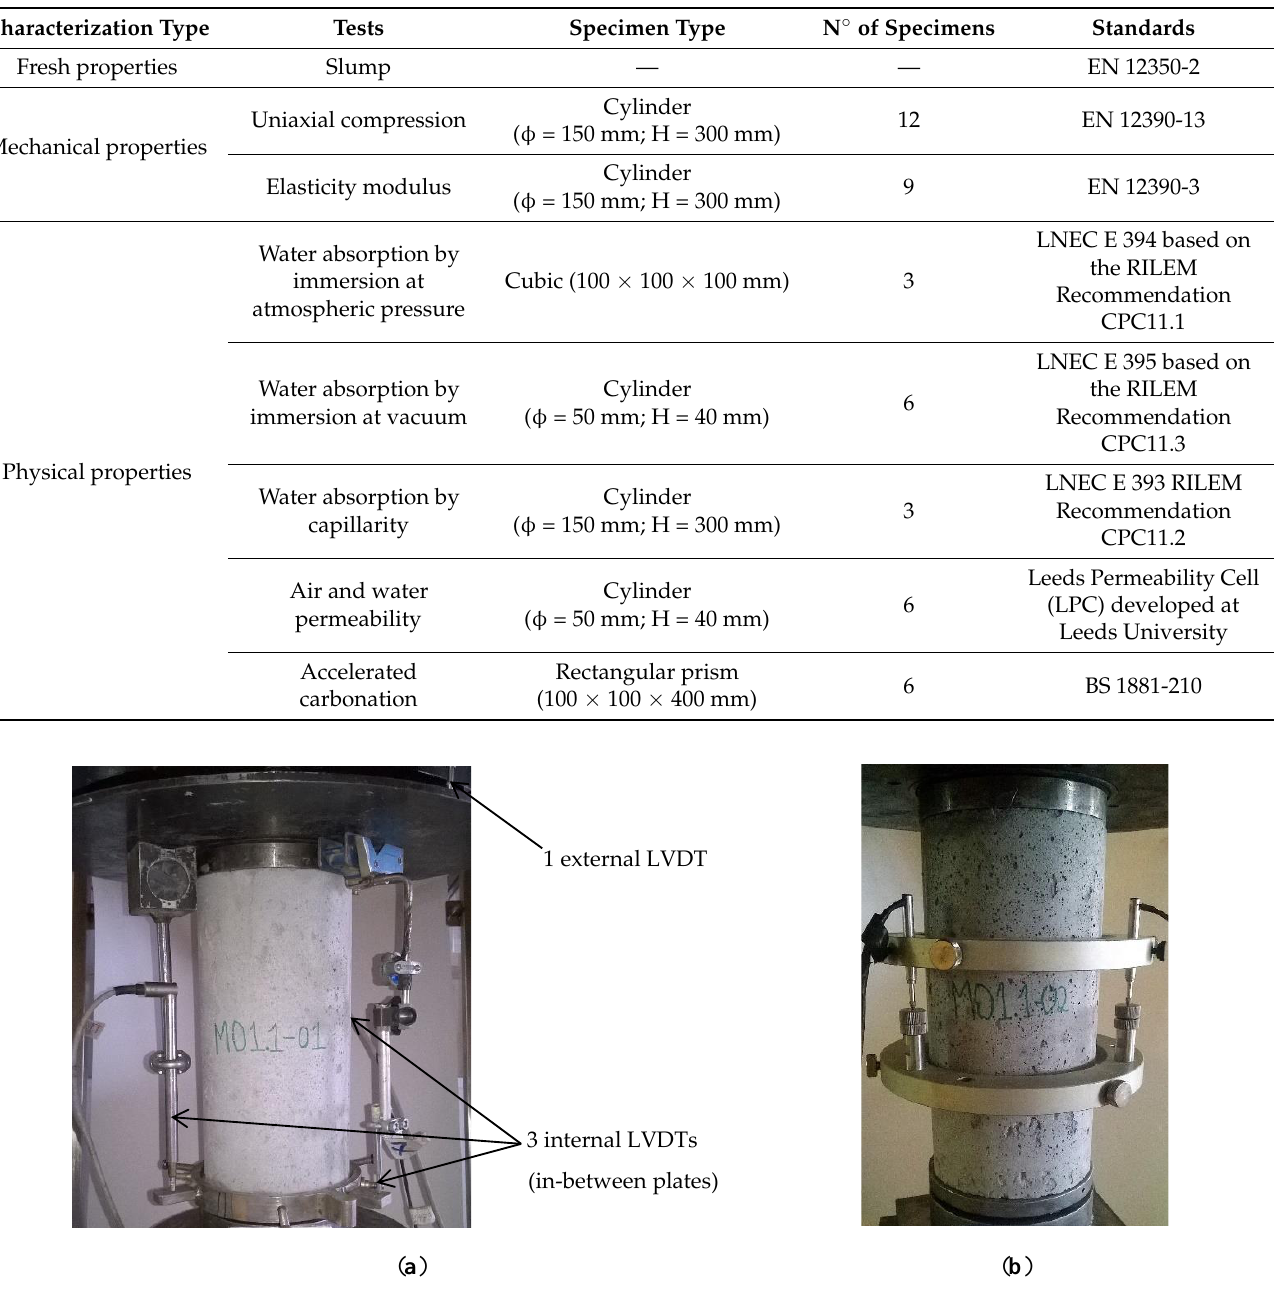
Figure 4. Experimental set-up: ( a ) uniaxial compression test; ( b ) elasticity modulus.